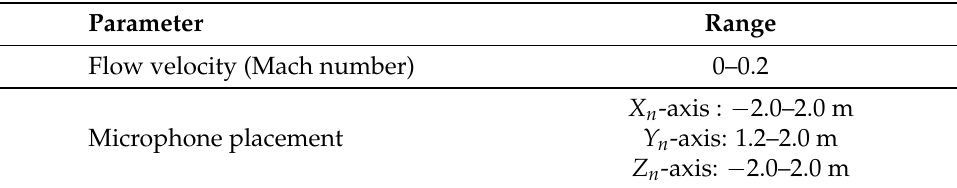
Table 1. The flow velocity and the microphone placement area to be